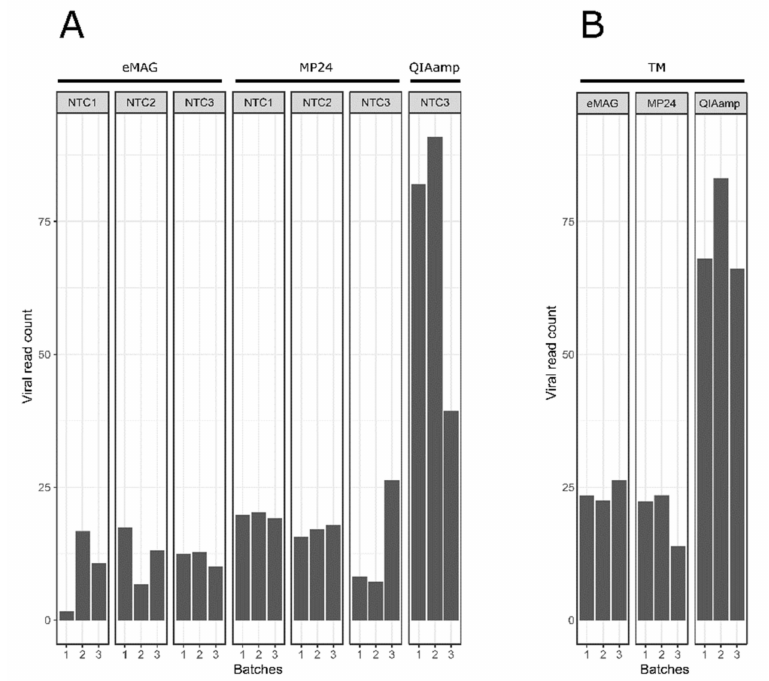
Figure 6. Proportion of Kitome contained in each triplicate from the di ff erent extraction methods ( A ) in NTC and ( B ) in the transport medium. Bar plot showing the sum of the viral read count normalized in log 10 (RPM), associated with reagent contamination (i.e., reads associated with other viruses than the targeted viruses: kitome) for each NTC and TM compared between di ff erent extraction methods. During automated extractions, NTCs were interspersed between samples (i.e., 3 NTCs per batch). For manual extractions, only one NTC was added. In addition to the NTC, a transport medium was added. Analyses were performed at the family taxonomy level. A sample was considered to be positive